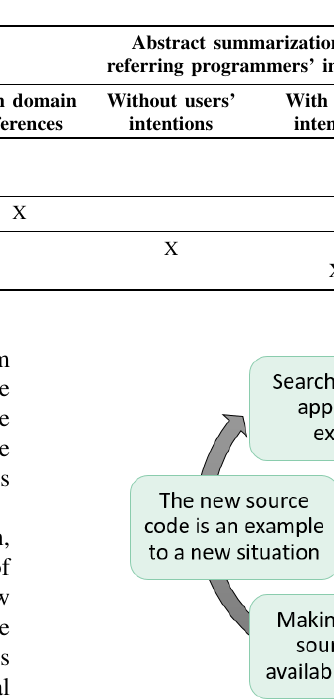
TABLE V A PPROPRIATION CLASSIFICATION ACCORDING TO UNDERSTANDING LEVELS